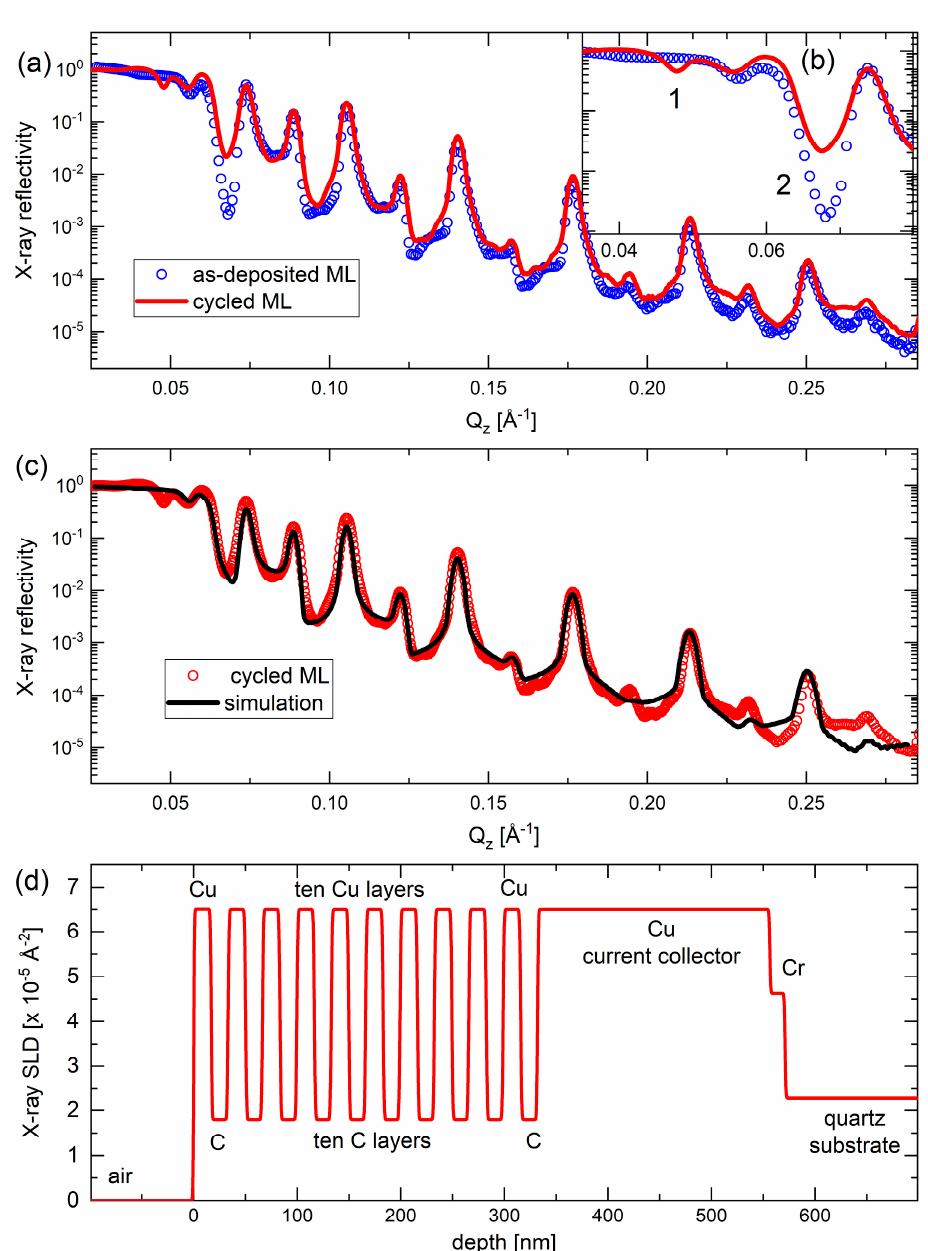
Figure 10. ( a , b ) XRR patterns of the C/Cu ML electrode before being mounted in the electrochemical cell (blue circles), measured on a Panalytical Empyrean diffractometer, and after cycling, washing, and air exposure for 15 months (red line), measured on a Bruker D8 DISCOVER diffractometer. Panel ( b ) is a cutout of ( a ). ( c ) XRR pattern (red circles) and XRR-simulation results (black line) on the C/Cu ML electrode after cycling, washing, and 15 months of air exposure. ( d ) Depth profile of the X-ray scattering length density of the XRR-simulation results presented in ( c ). A color version of this figure can be viewed online.